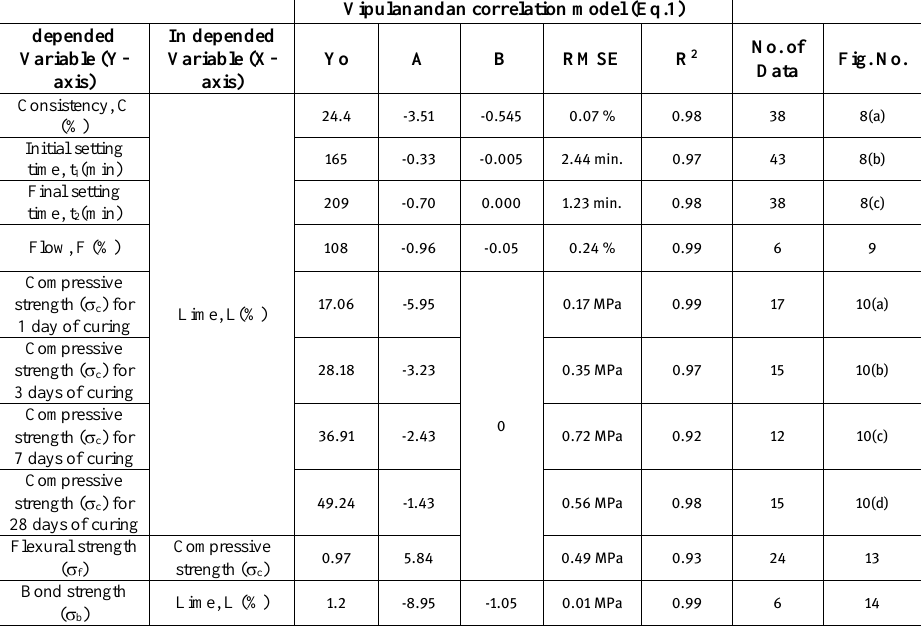
Table 6: Model parameters of plastic and hardened properties of cement mortar modified lime